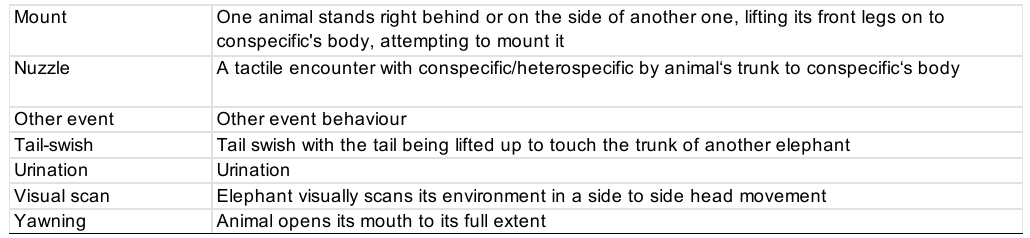
Figure A1. Ethograms used to code behavioral observations of focal animals.